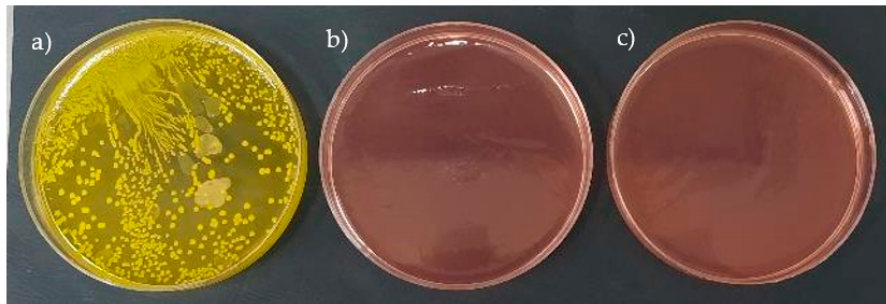
Figure 10. Antibacterial activity results.: reference material—( a ), T15—( b ), S15—( c ).